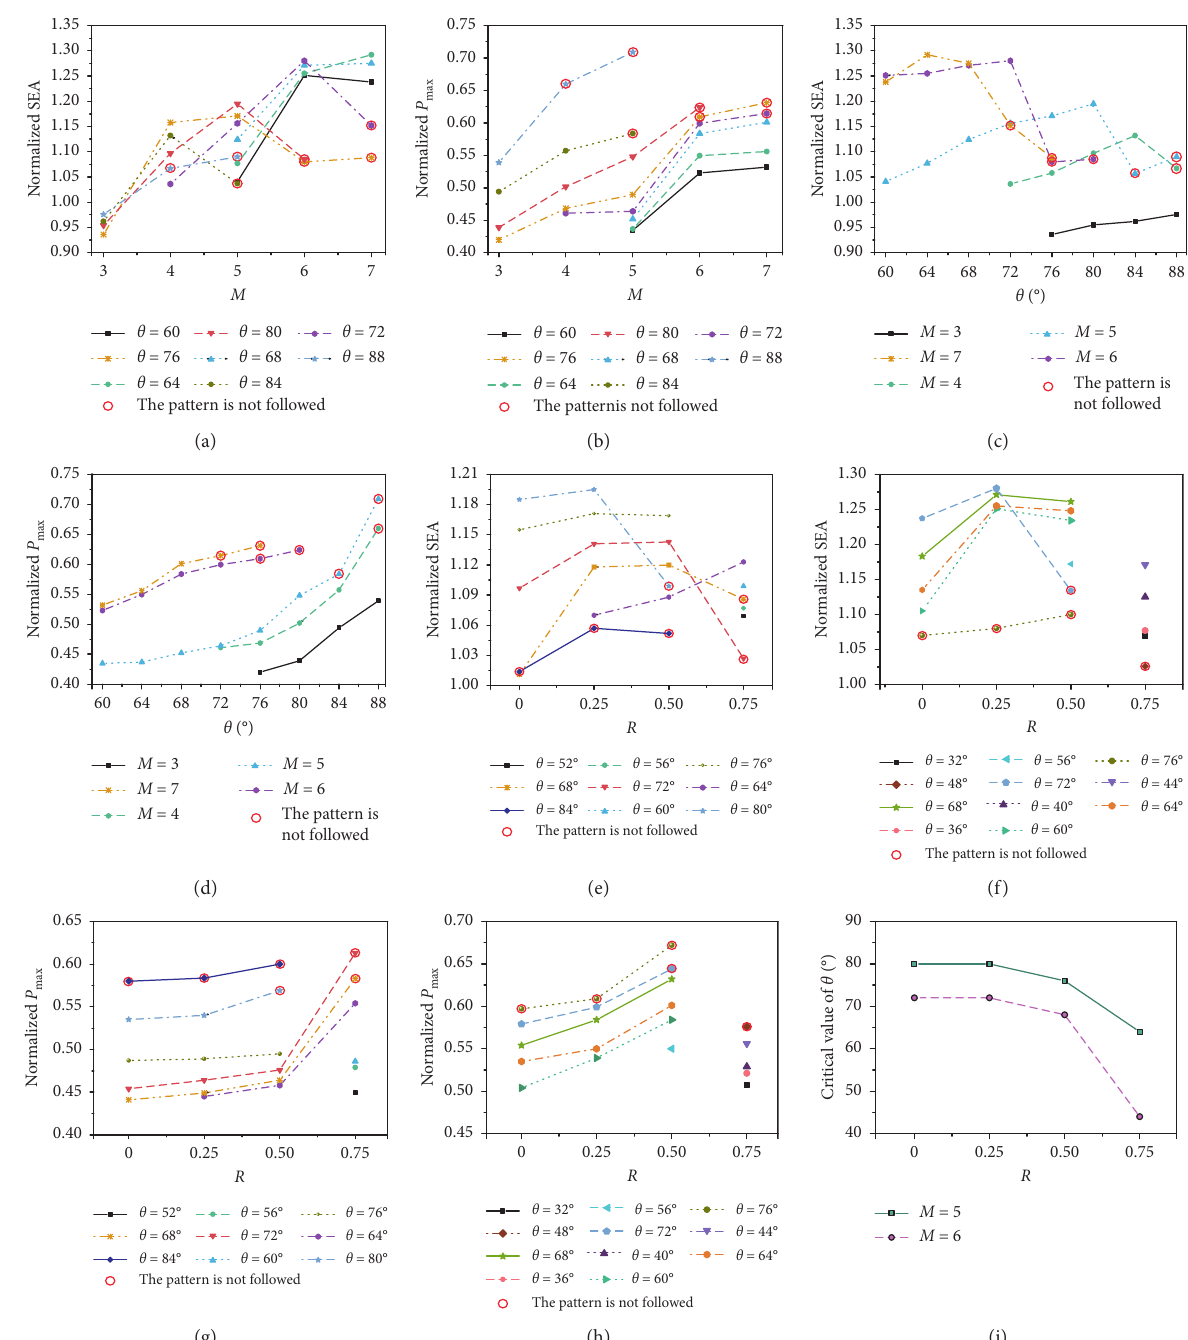
Figure 8: Relationship between the (a) normalized SEA and M , (b) normalized P and θ , normalized SEA and R at (e) M � 5 and (f) M � 6, normalized P for square patterned